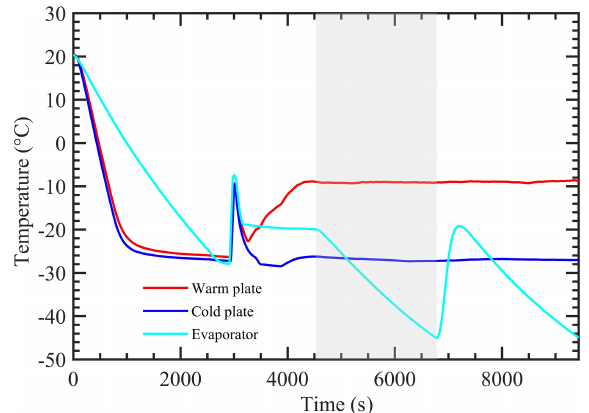
Figure 2. Measured temperature of warm, cold, and nucleation sec- tion walls during a typical experiment. The shaded area indicates the experimental conditions during one ice nucleation measurement. During this INP measurement, the temperature of both warm and cold walls is kept constant, while the nucleation section is cooled at a steady rate (0.5 ◦ Cmin − 1 ).